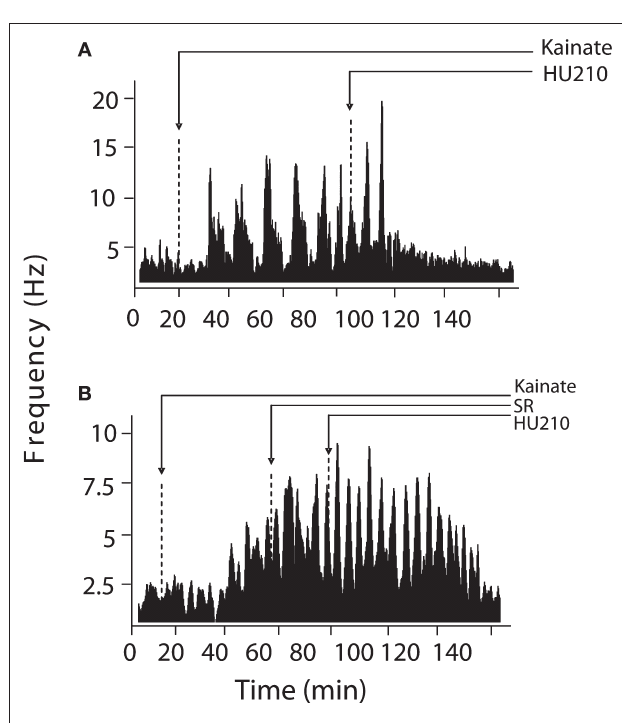
FIGURE 3 | Modulation of KA-induced slow oscillations in fi ring by CB1 receptors. (A) Representative integrated fi ring rate histograms (bin width 10 s) illustrating KA-induced macro-burst fi ring pattern (periodicity ∼ 200 s). Injection of HU210 abolished this slow oscillatory fi ring activity. (B) Pre- treatment with the CB1 antagonist rimonabant (SR) completely blocked the actions of HU210. Arrow heads indicate the time of HU210 (100 µg kg − 1 ) or rimonabant (3 mg kg − 1 ) injections during KA (10 mg kg − 1 ). All doses i.p.